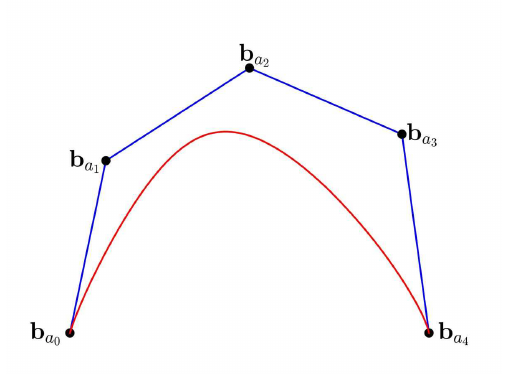
Figure 7: Quadratic GT-Bézier